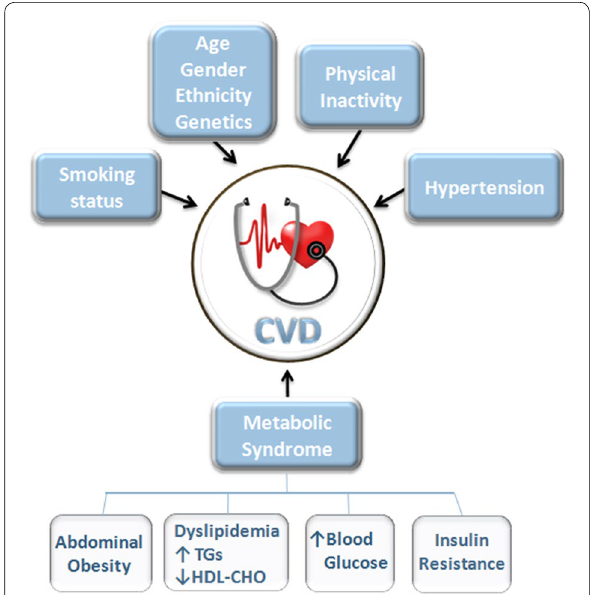
Fig. 3 Scheme of cardio‑metabolic risk factors associated with the prevalence of cardiovascular disease